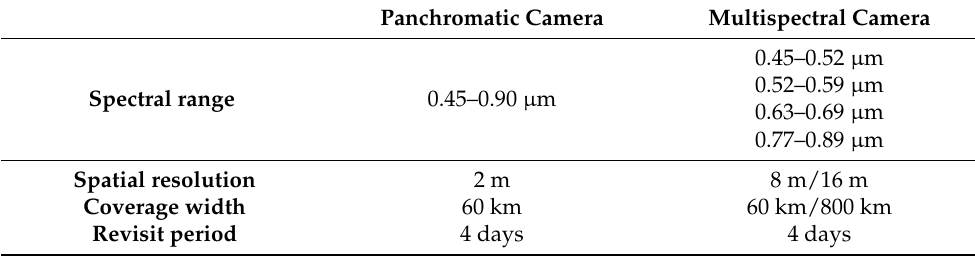
Table 1. GF-1 satellite